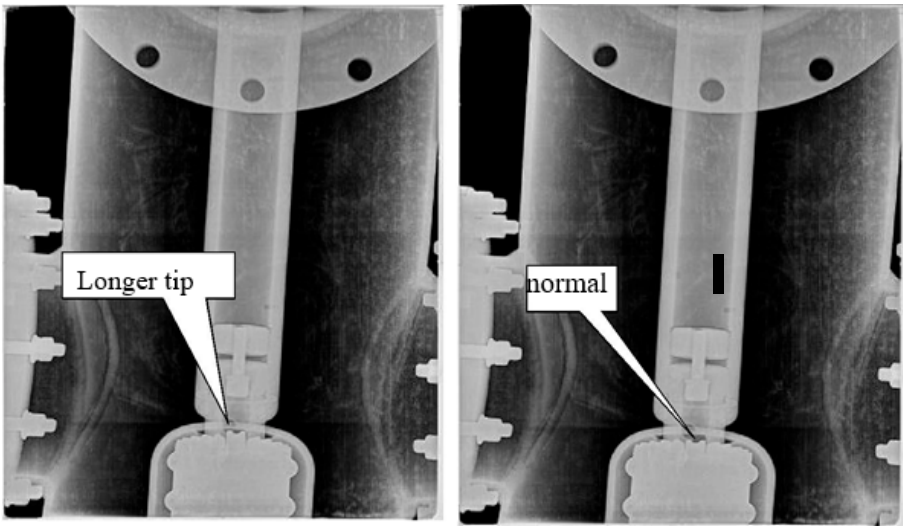
Figure 17. The long metal tip in the grading shield with no partial discharge.